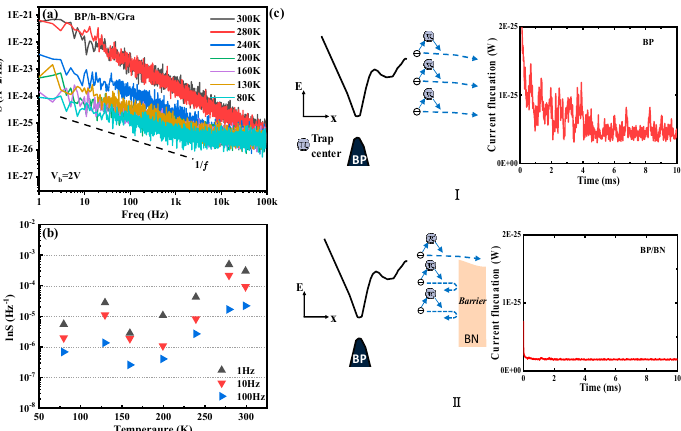
Figure 6. ( a ) Noise spectral density S(I 2 ) for the black phosphorus (BP) / boron nitride (h-BN) / graphene device at various temperatures. The source-drain bias was 2 V. Note that the 1 / f noise decreases as the temperature decreases. S(I 2 ) is two orders-of-magnitude smaller at a relatively low temperature (80 K) than that at room temperature. ( b ) Noise spectral density as a function of the temperature at 2 V bias. ( c ) Energy band diagrams near the BP (I part) and BP / BN (II part) contact representing the current fluctuation probability. The left panel in each part shows carrier transport and the right panel in each part shows current fluctuations in the time domain at the same current values and temperature.